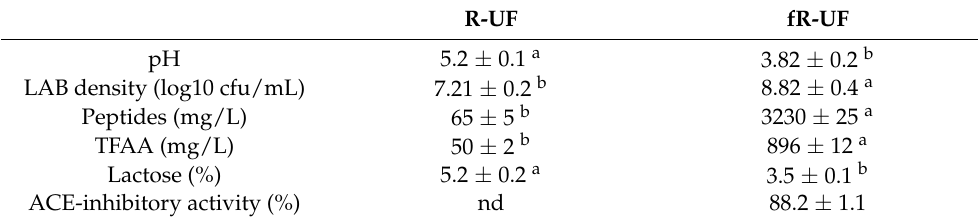
Table 3. Characteristics of the RCEW fractions R-UF (prior fermentation) and fR-UF (after fermenta- tion with Lactobacillus helveticus PR4 at 37 ◦ C for 24